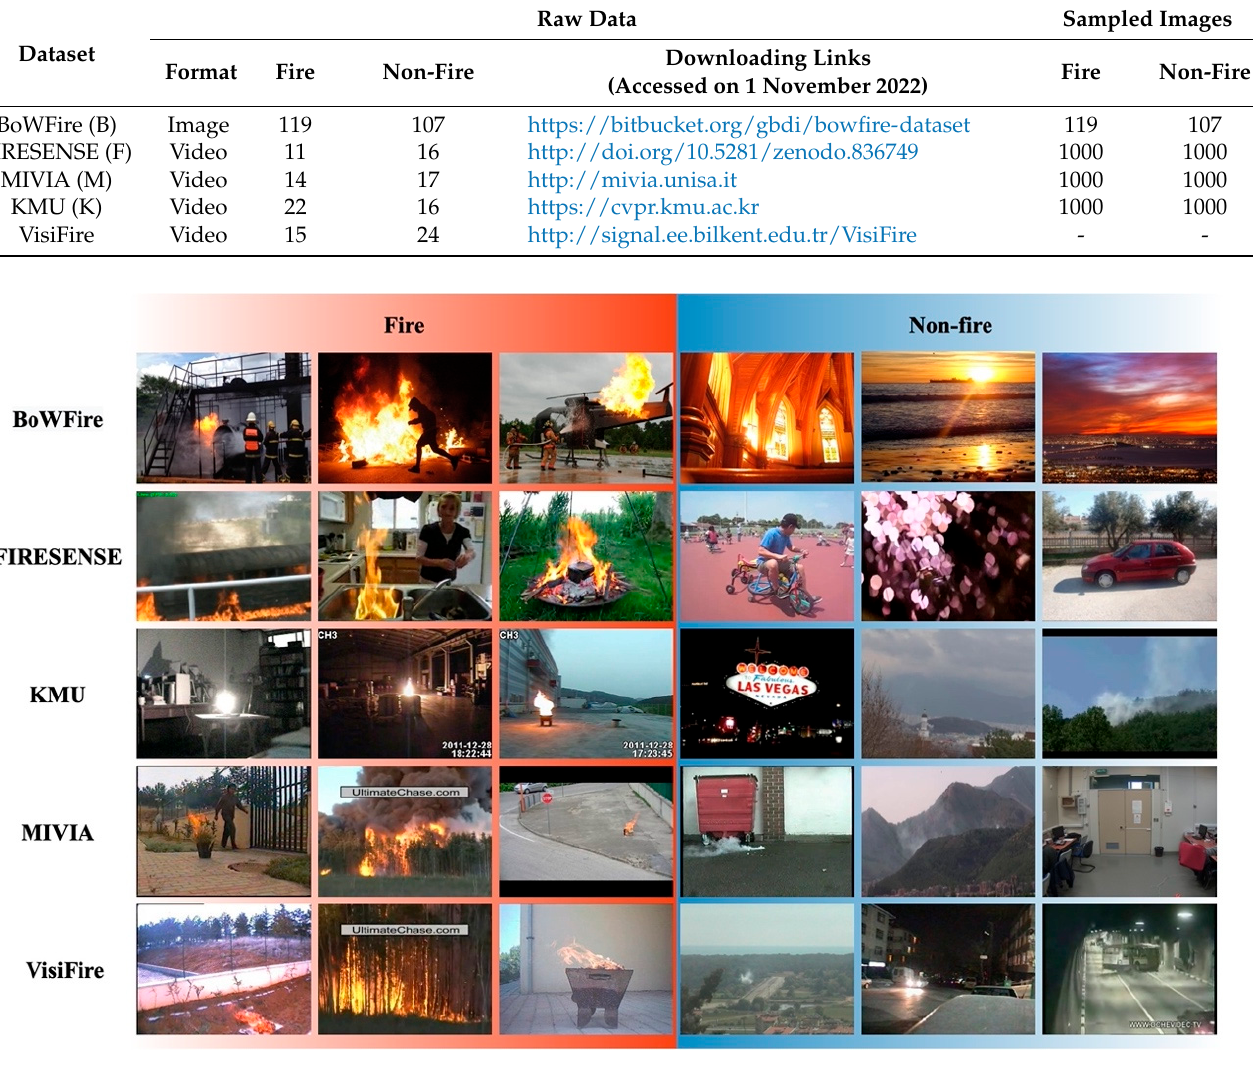
Figure 2. Some sample images from five public fire datasets. Columns one to three show fire sam- ples and columns four to six illustrate non-fire samples. and columns four to six illustrate non-fire